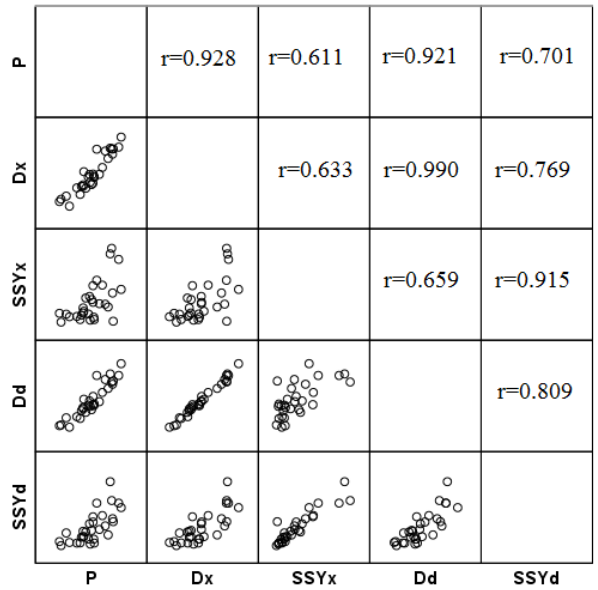
Figure 4. Bivariate scatter-plot matrix of selected variables.